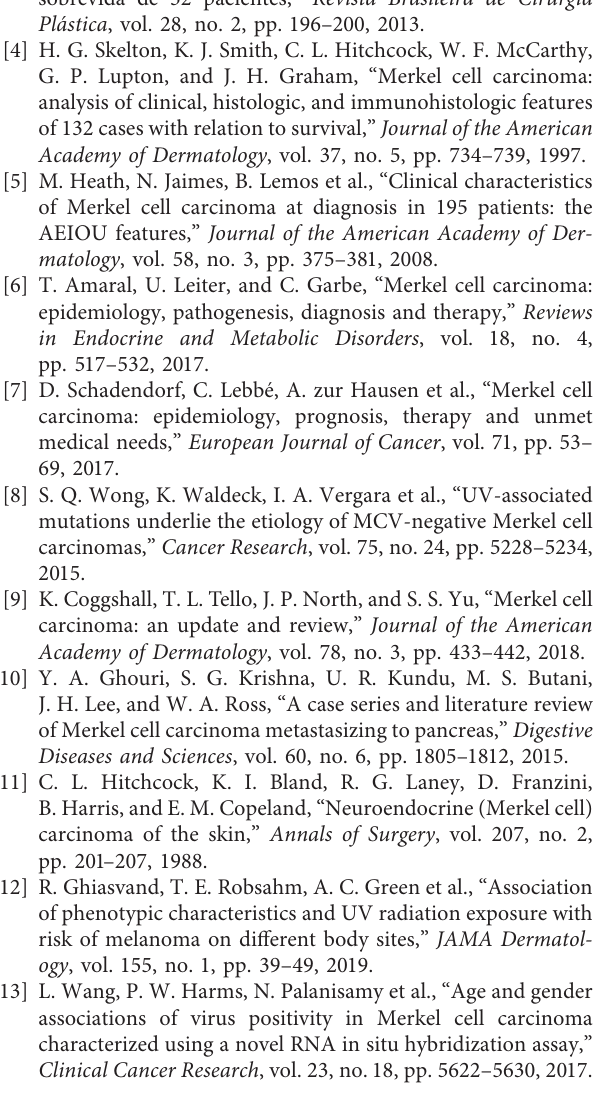
Table 4: Neuroendocrine markers vs. CK-20